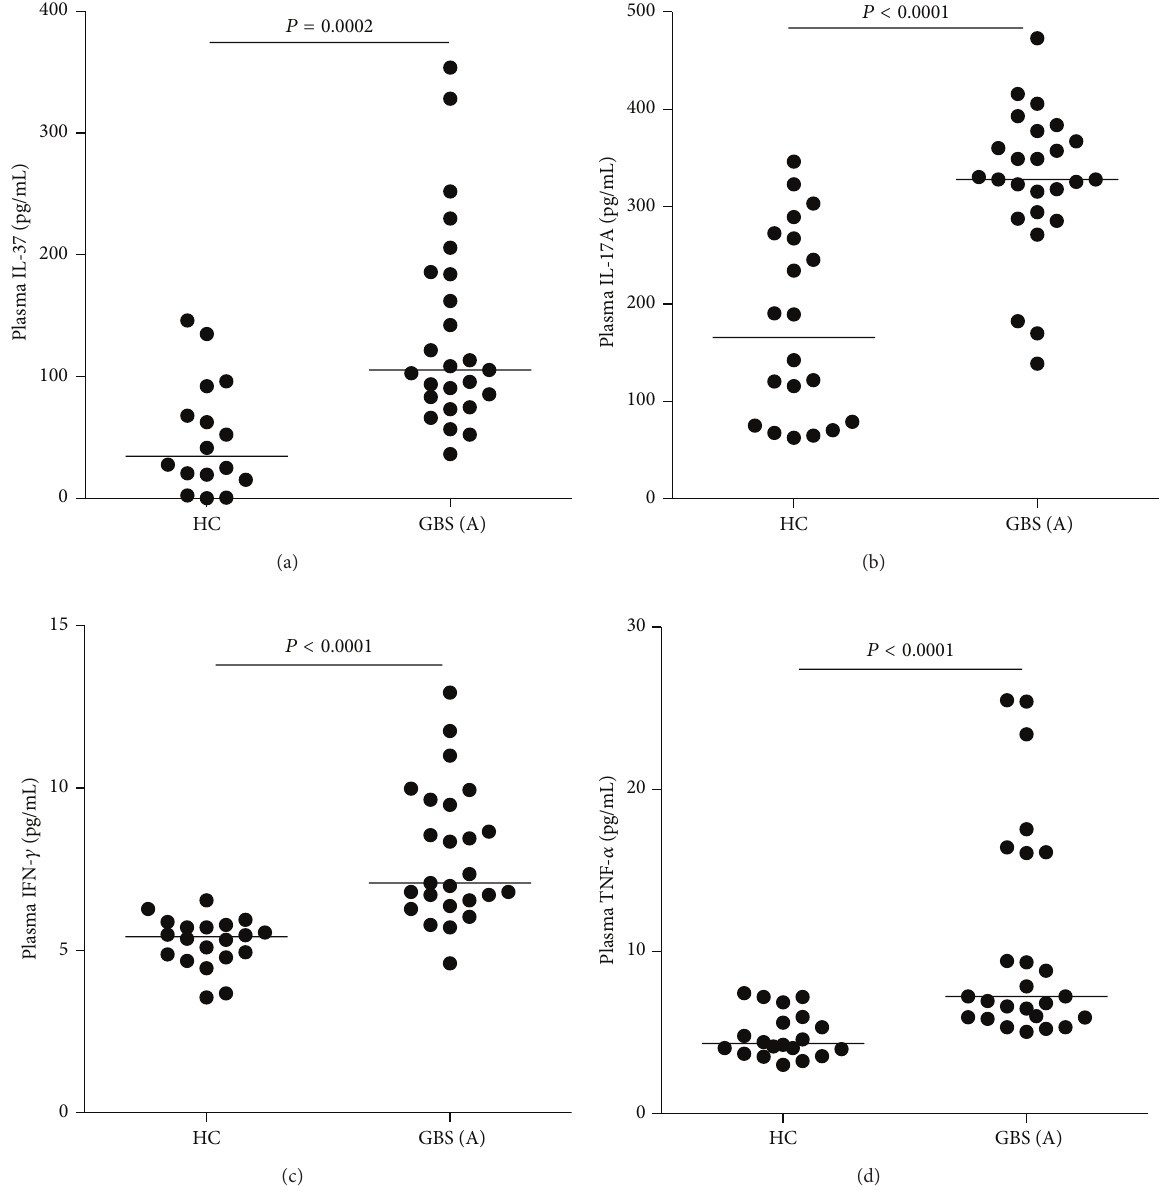
Figure 1: The levels of plasma cytokines in individual subjects. The concentrations of plasma IL-37 (a), IL-17A (b), IFN- 𝛾 (c), and TNF- 𝛼 (d) in individual patients with new onset GBS ( 𝑛 = 25 ) and the HC ( 𝑛 = 20 ) were determined by ELISA and CBA, respectively. Data shown are the mean values of individual subjects from three separate experiment, and the horizontal lines indicate the median values of individual